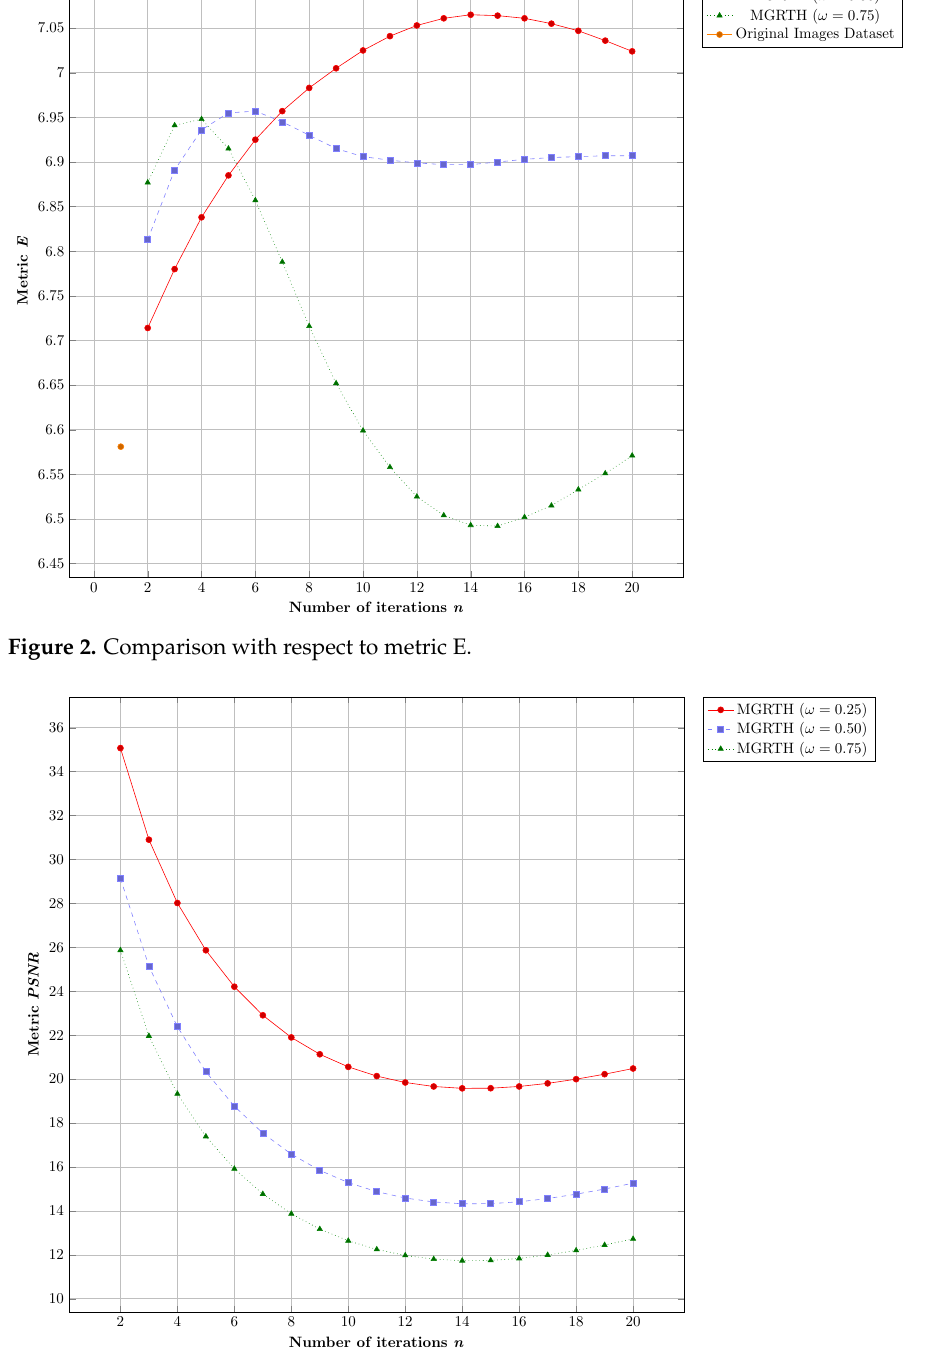
Figure 3. Comparison with respect to metric